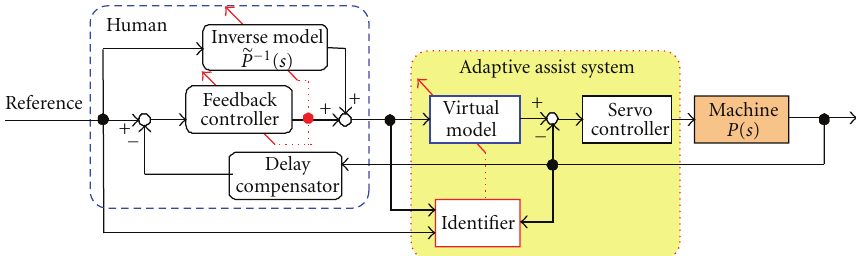
Figure 2: Structure of human assistive system with the adaptive impedance control.